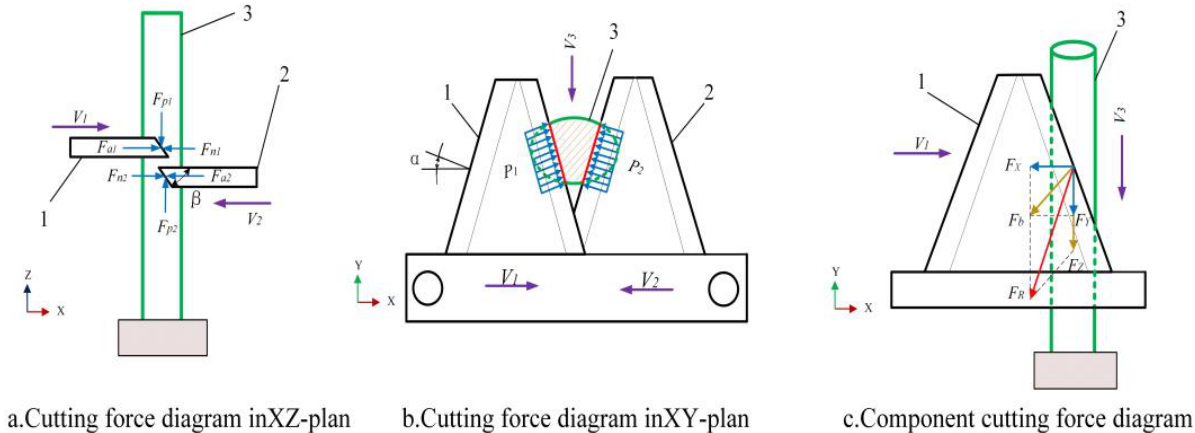
Figure 2. Reciprocating cutter-system cutting force diagram: 1 — upper cutting blade; 2 — bottom cutting blade; 3 — stalk.